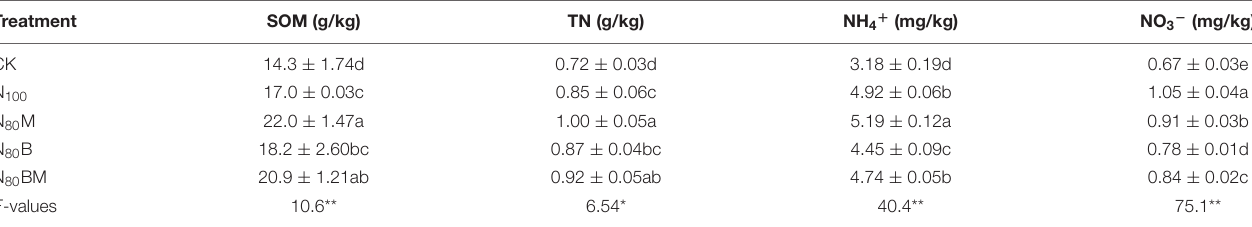
TABLE 4 | Effects of applying rice straw biochar and/or leguminous cover crop residue on the contents of soil organic matter (SOM), total N (TN), NH 4 + , and NO 3 − after harvesting rice plants. Treatment SOM